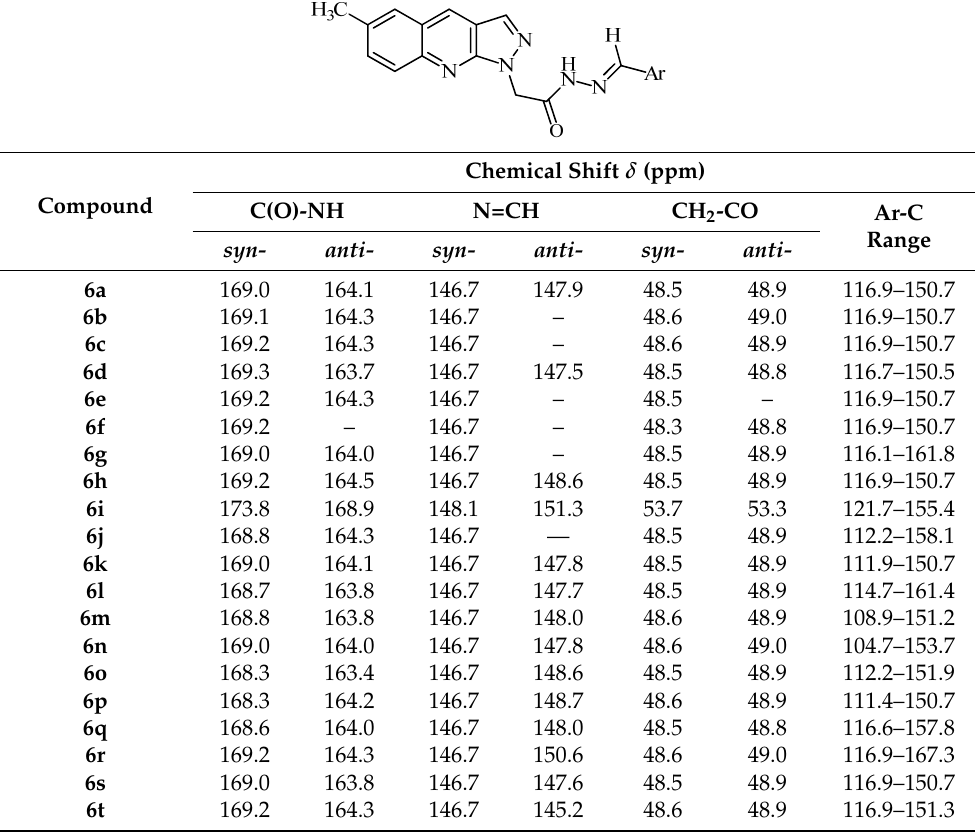
Table 3. Data of distinct peaks in 13 C NMR spectra of compounds 6 ( a – t ) in DMSO- d 6 .